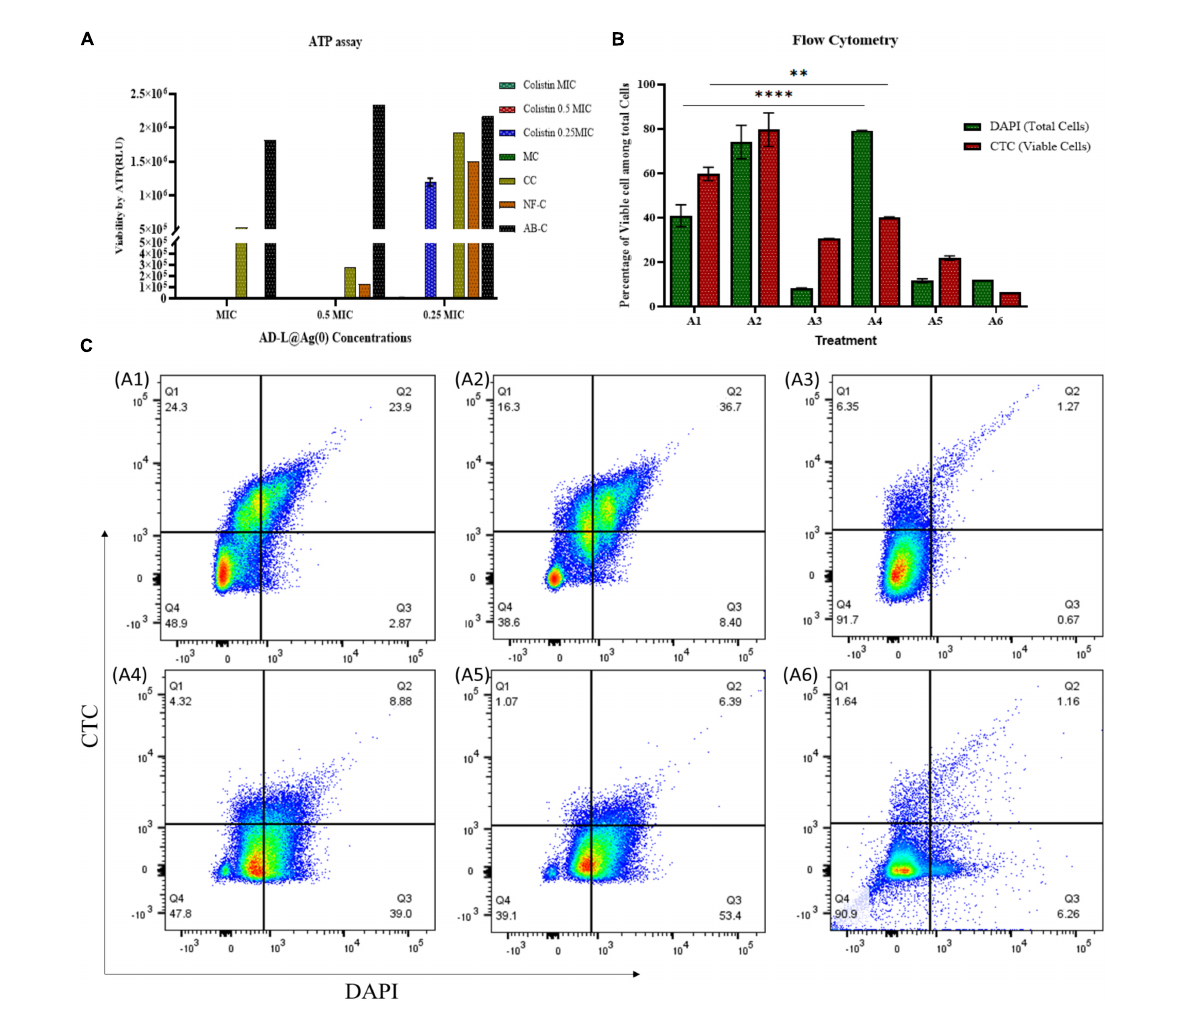
FIGURE3 Determination of potentiating ability of AD-L@Ag(0) by estimation of cell viability: The viability of ABin the presence of various combinations of MICs of colistin and AD-L@Ag(0) was analyzed using ATP assay, flow cytometry, and by confocal laser scanning microscopy (CLSM). (A) ATP assay: The graph represents presence/absence of ATP production at various combinations of colistin + AD-L@Ag(0). The x -axis in the graph represents various concentrations of MICs (MIC, 1 / 2 MIC, 1 / 4 MIC) of AD-L@Ag(0); whereas the y -axis represents viability by ATP in terms of RLU (relative light unit). The color bars represent different concentrations of colistin (MIC, 1 / 2 MIC, and 1 / 4 MIC) with controls: CC, colistin control; NF-C, nano-formulation control [AD-L@Ag(0)]; AB-C, Acinetobacter baumannii control; MC, media control. The graph suggested similar results as those obtained from CFU and OD calculation. The RLU of ATP at colistin 1 / 2 MIC + AD-L@Ag(0) 1 / 4 MIC was found to be zero indicating bactericidal effect on resistant AB strain. (B) Flow cytometry: The viability percentage of ABin various combinations of colistin and AD-L@Ag(0) was analyzed by flow cytometry using DAPI and CTC staining. The x -axis represents the treatment of ABat various combinations and the y -axis represents the percentage of viable cells among total cells. A1: Acinetobacter baumannii control (AB-C), A2: Colistin control (CC), A3: Nano-formulation control [AD-L@Ag(0)] (NF–C), A4: 1 / 2 MIC col + 1 / 4 MIC AD − L@Ag ( 0 ) , A5: 1 / 4 MIC col + 1 / 2 MIC AD − L@Ag ( 0 ) , and A6: 1 / 4 MIC col + MIC AD − L@Ag ( 0 ) . Flow cytometry analysis indicated that at colistin 1 / 2 MIC + AD-L@Ag(0) 1 / 4 MIC (A4), the difference between viable cells (CTC stained) to total cells (DAPI stained) was very huge. This means that the percentage of viable cells was very low when compared to total cells; indicating bactericidal effect at this combination. (C) Pseudo-color plot (Flow cytometry): The graph represents four quadrant images with the percentage of cells in each quadrant observed by flow cytometric analysis. Q1: Shows AB cells stained with CTC only, Q2: Shows AB cells stained with both CTC and DAPI, Q3: Shows AB cells stained with DAPI only, Q4: Shows AB cell debris. A1: Acinetobacter baumannii control (AB-C), A2: Colistin control (CC), A3: Nano-formulation control [AD-L@Ag(0)] (NF–C), A4: 1 / 2 MIC col + 1 / 4 MIC AD − L@Ag ( 0 ) , A5: 1 / 4 MIC col + 1 / 2 MIC AD − L@Ag ( 0 ) , and A6: 1 / 4 MIC col + MIC AD − L@Ag ( 0 ) . ** (0.0081) Shows the significant difference between AB–C and 1 / 2 MIC col + 1 / 4 MIC AD − L@Ag ( 0 ) (TOTAL CELLS). **** (<0.0001) Shows the significant difference between AB–C and 1 / 2 MIC col + 1 / 4 MIC AD − L@Ag ( 0 ) (VIABLE